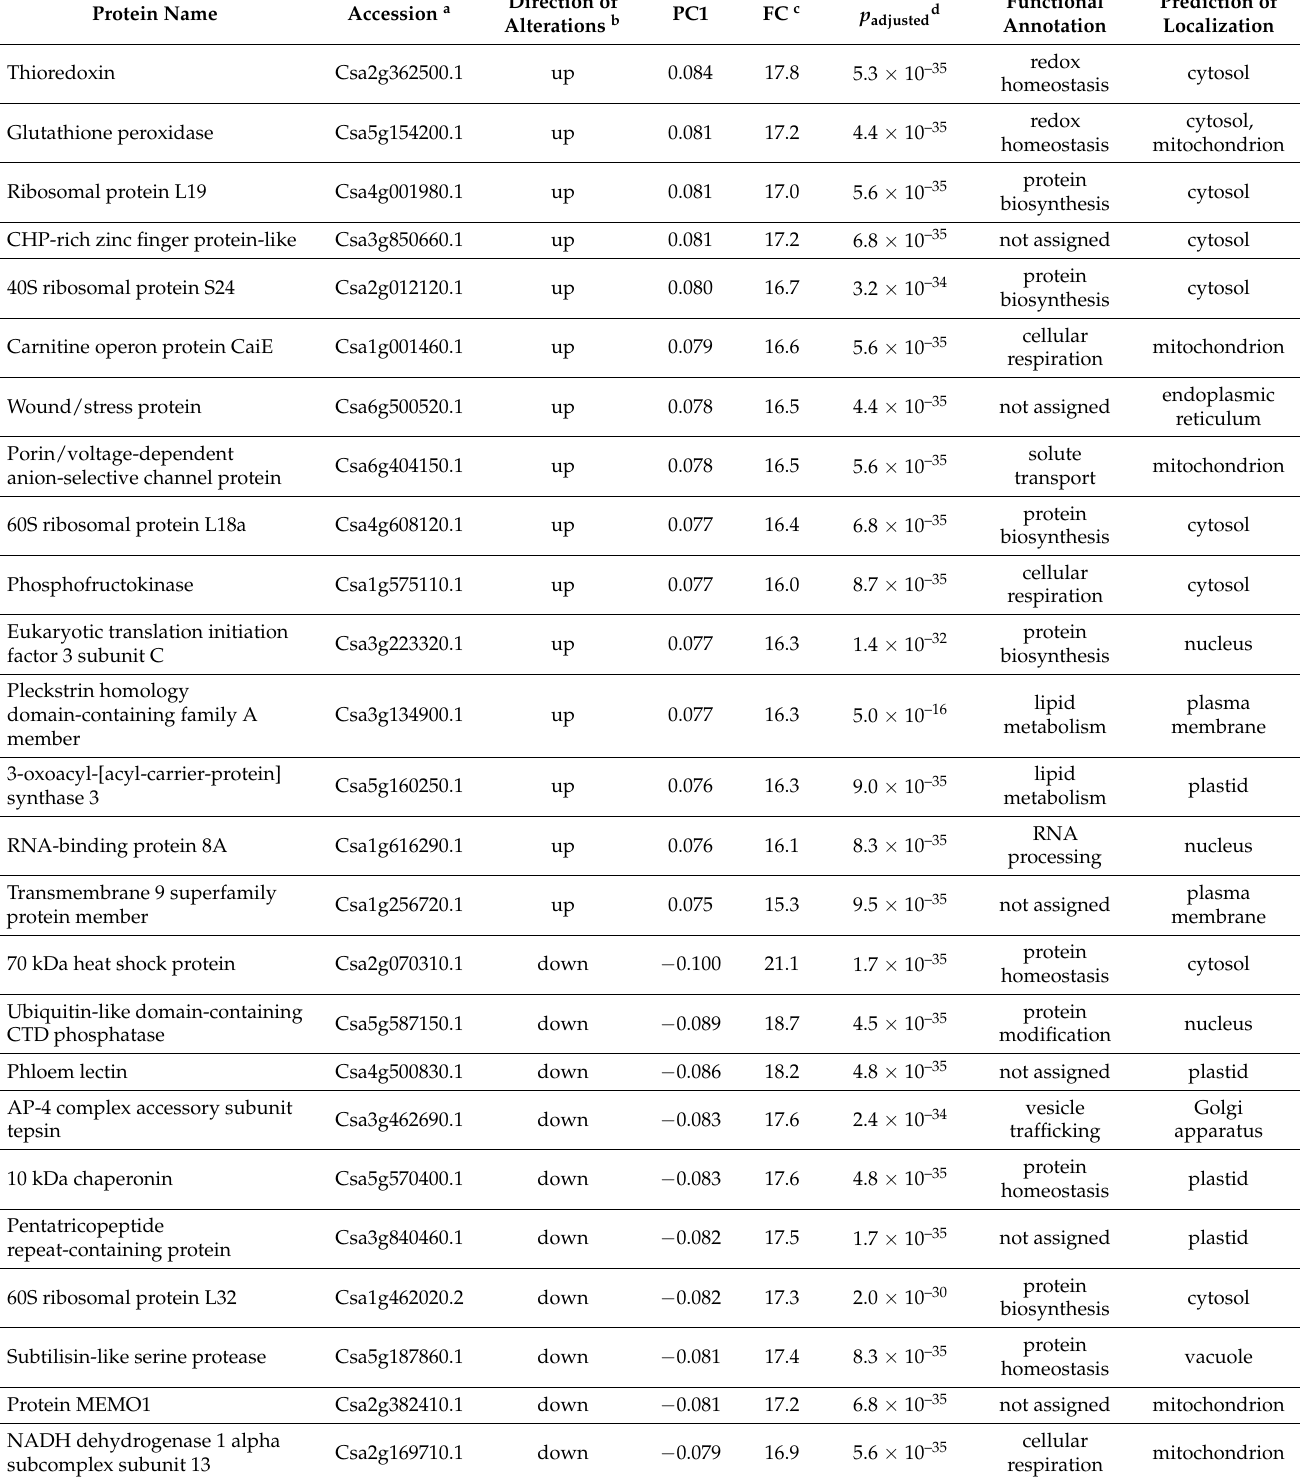
Table 2. Top 25 differentially expressed proteins with the highest impact on the inter-group differences observed in the principal component analysis performed for 208 differentially expressed